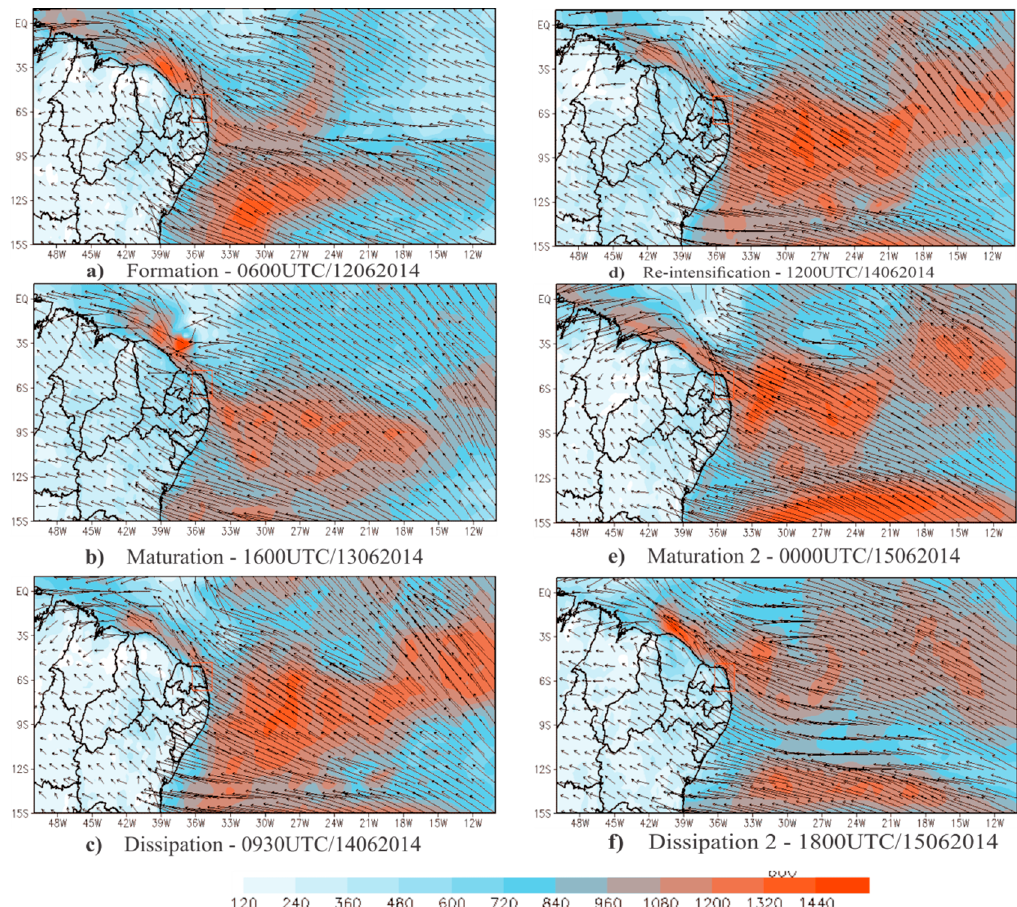
Figure 5. Specific moisture flux (kg water/kg air) vertically integrated in the phases ( a ) formation, ( b ) maturation, ( c ) dissipation, ( d ) re-intensification, ( e ) 2nd maturation, ( f ) 2nd dissipation of the Eastern Wave Disturbance.